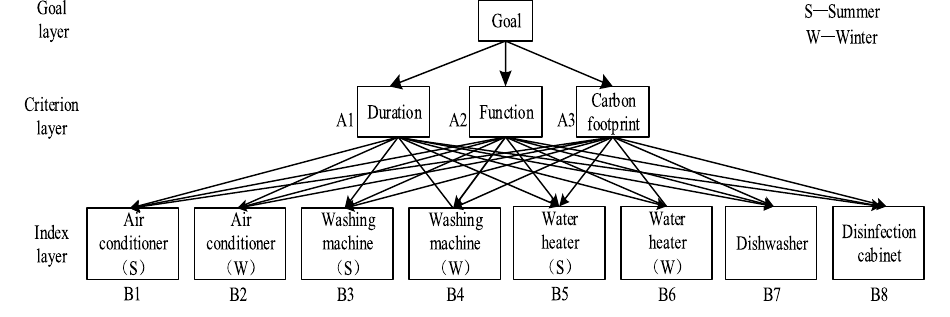
Figure 1. Fuzzy hierarchical diagram.